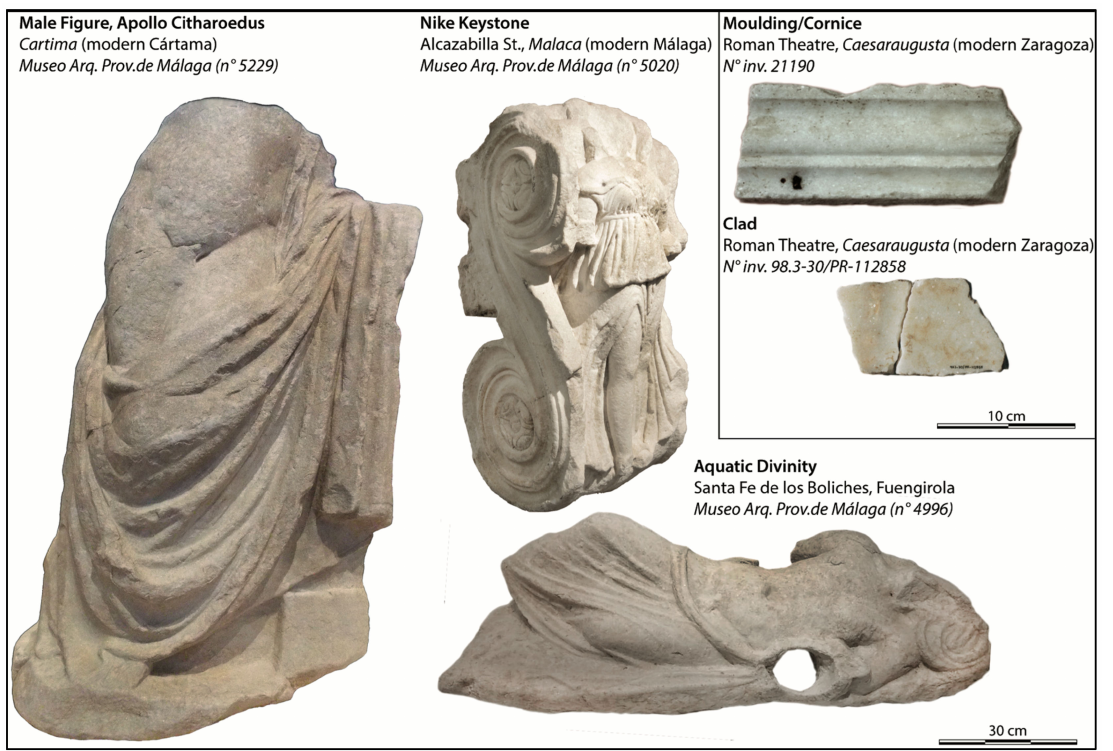
Figure 1. Artifacts studied in this work. Male Figure (29 MM), Nike Keystone (6 MM), Aquatic Divinity (26 MM) from the M á laga museum (credit M á laga museum). Moulding (CL) and Clad (BL) from the Roman Theatre of Zaragoza (credit, Roman